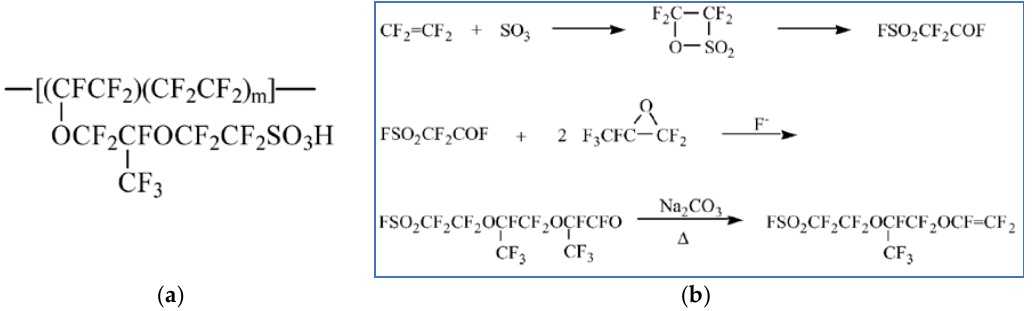
Figure 3. The chemical structure of Nafion ( a ) and the synthesis process for the vinyl ether monomers, the starting point for Nafion ( b ). (b) is reprinted with permission from Ref. [20]. Copyright 2004 Elsevier.